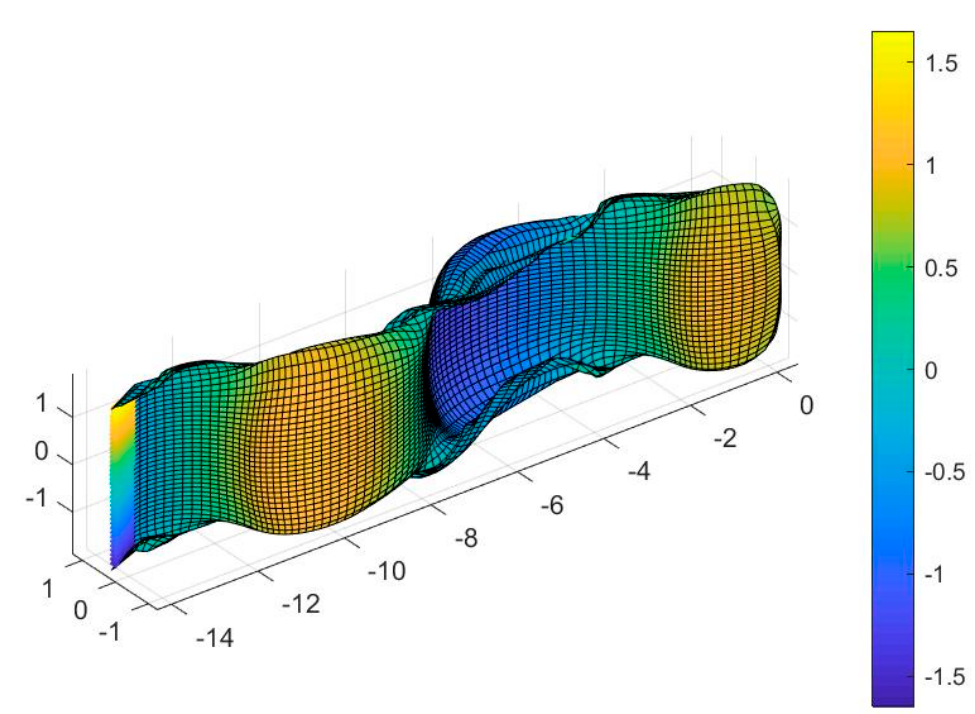
Figure 8. Three-dimensional plot of vortex wake of oscillating trapezoidal wing of aspect ratio AR = 3.4, for U = 0.5 m/s, reduced frequency k = 0.1, pitching amplitude θ 0 = 50 ◦ and heaving amplitude h / c = 0.41. Note that for clarity a scale = 10 has been used in the plot for both horizontal and vertical axes.